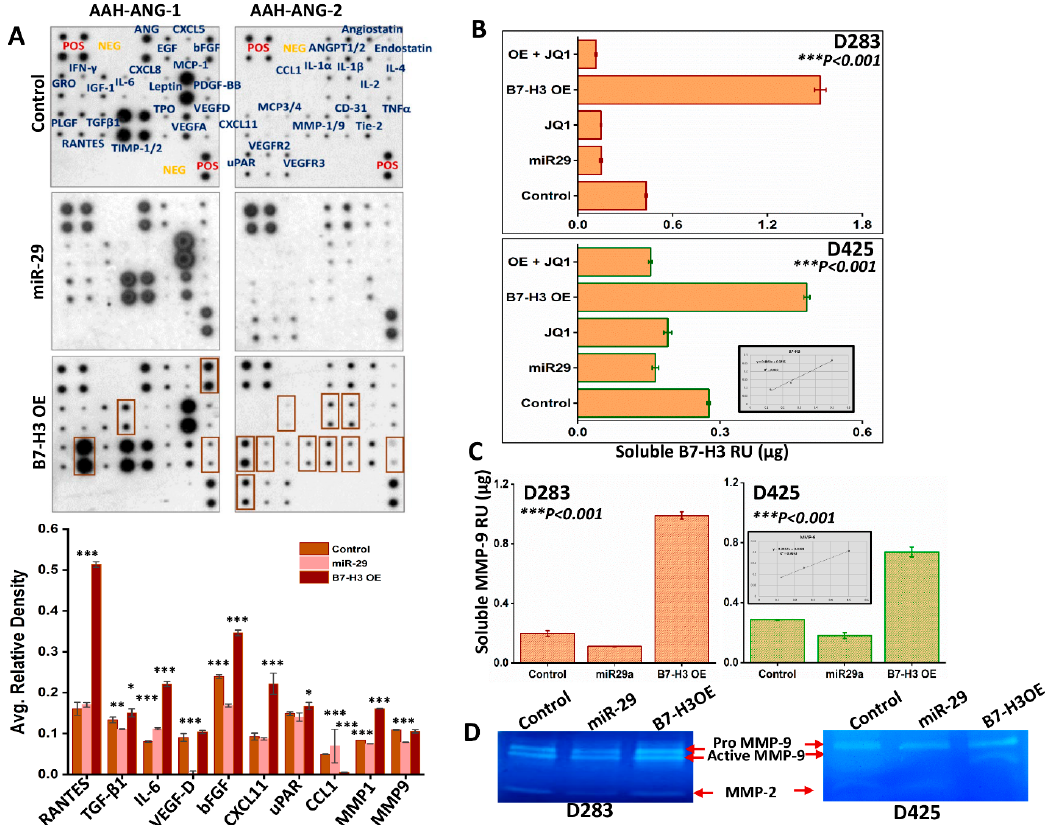
Figure 4. B7-H3 promotes pro-angiogenic molecules released into extracellular medium. ( A ) ( Top ) Human Antibody Angiogenesis Array (RayBiotech, AAH-ANG-1 and 2) incubated with conditioned media from control, miR-29-transfected, or B7-H3 OE-transfected D283 cells, collected 48 h after transfection. ( Bottom ) Densitometry graphs showing difference in average relative density of array proteins ( n = 4 for each protein). ( B ) Soluble B7-H3 levels from D283 and D425 cell conditioned media assessed by ELISA ( R 2 = 0.983) ( n = 4 for each treatment). ( C ) Soluble MMP-9 levels from D283 and D425 cells transfected with miR-29 plasmid or B7-H3 OE plasmid, 48 h after transfection ( R 2 = 0.993) ( n = 4 for each group). ( D ) MMP-2 and MMP-9 activity levels assessed by gelatin zymography using conditioned media from D283 and D425 cells collected 48 h after transfection. * p < 0.05, ** p < 0.01, *** p < 0.001.